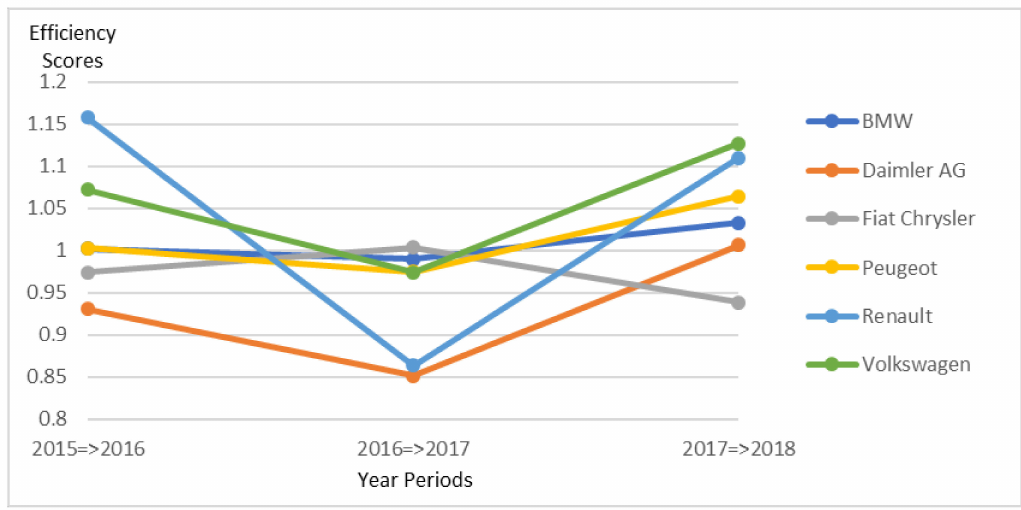
Figure 6. Technical-e ffi ciency changes of European